Question: Looking at the figure, what chart type is it?
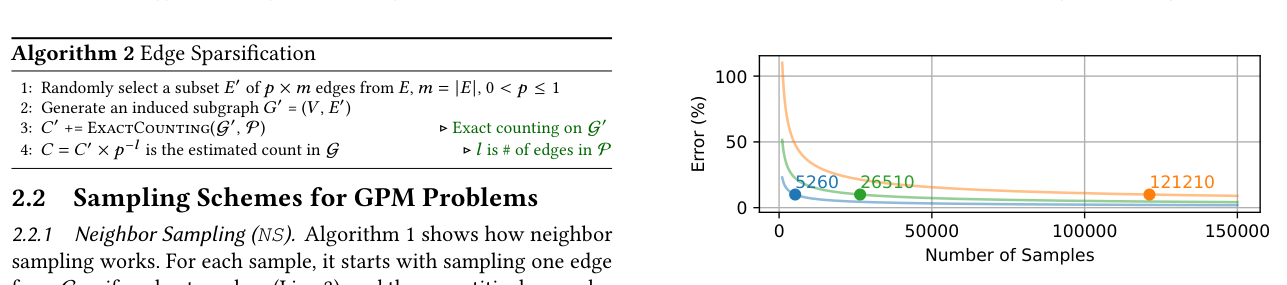
Answer: line